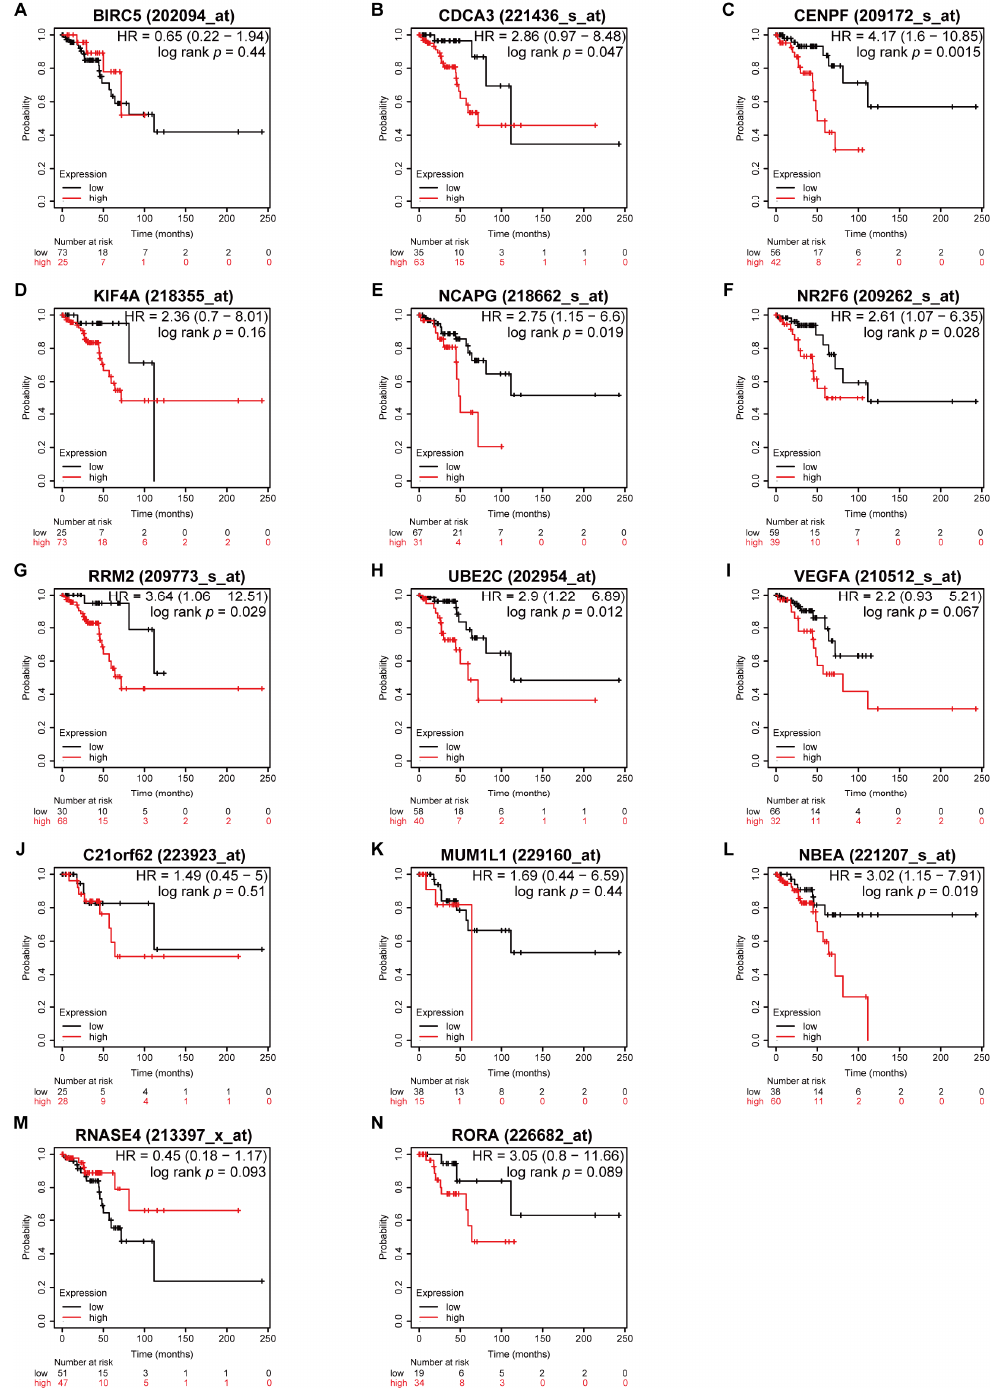
Figure 7. Survival analyses of the dysregulated genes in the early stages of serous ovarian cancer. Kaplan–Meier plots of overall survival in subjects with higher versus lower expression. ( A ) BIRC5 , ( B ) CDCA3 , ( C ) CENPF , ( D ) KIF4A , ( E ) NCAPG , ( F ) NR2F6 , ( G ) RRM2 , ( H ) UBE2C , ( I ) VEGFA , ( J ) C21orf62 , ( K ) MUM1L1 , ( L ) NBEA , ( M ) RNASE4 , and ( N ) RORA mRNA